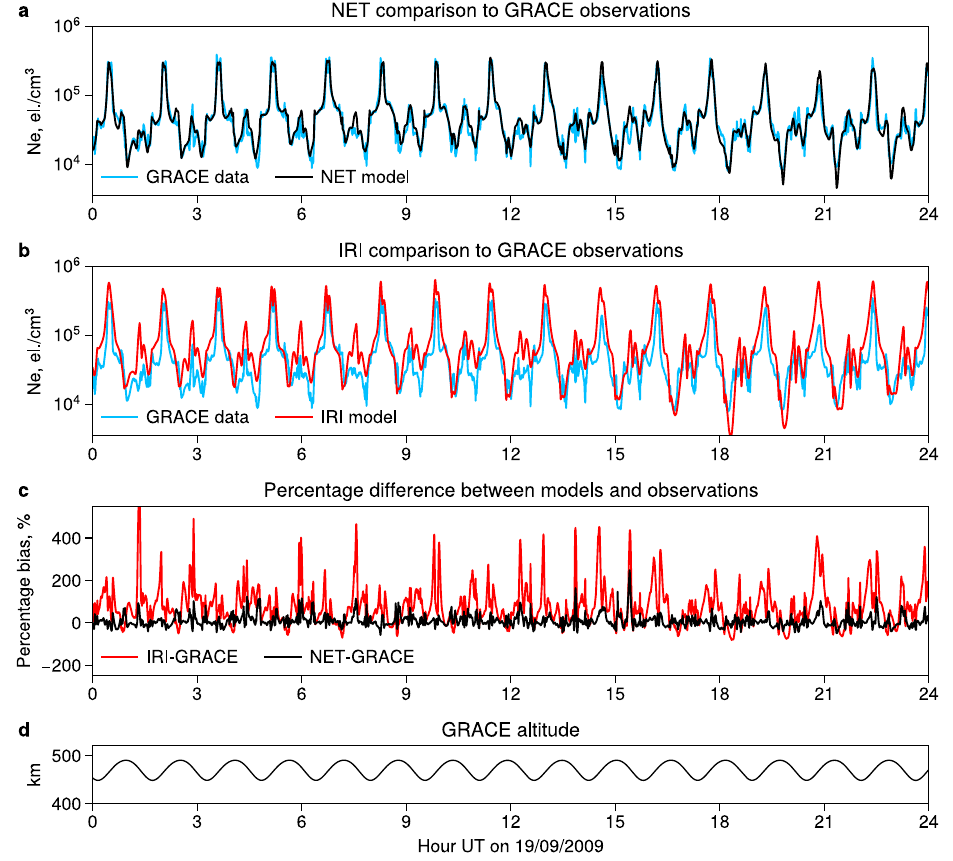
Figure 5. GRACE/KBR densities (shown in blue), compared to the NET predictions (panel a ), and IRI predictions (subplot b ) on 19 September 2009 (an example from the test interval). The percentage differences between the models and observations are given in panel ( c ). The GRACE altitude is shown in panel ( d